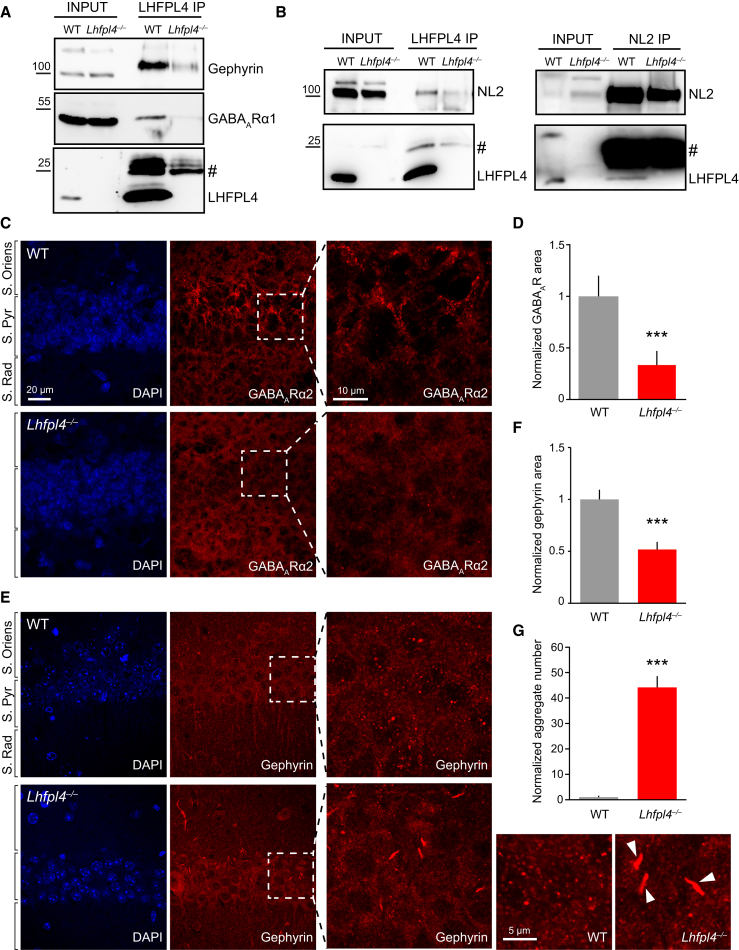
LHFPL4 Is Necessary for Gephyrin and GABAAR Clustering in Intact Brain(A) Co-immunoprecipitation (coIP) of gephyrin and GABAAR-α1 using an anti-LHFPL4 antibody from WT and Lhfpl4−/− mouse brain lysates (IP, immunoprecipitation; #, immunoglobulin G [IgG] light chain). Note that the immunoprecipitated 27-kDa band is visible just above the IgG light chain in the WT IP lane.(B) CoIP of neuroligin2 (NL2) using an anti-LHFPL4 antibody (left) and coIP of LHFPL4 using an anti-NL2 antibody (right) from WT and Lhfpl4−/− mouse brain lysates (IP, immunoprecipitation; #, IgG light chain).(C–F) Confocal images of adult WT and Lhfpl4−/− hippocampal brain sections immunolabeled with antibodies to (C) GABAAR-α2 and (E) gephyrin, co-stained with DAPI. Normalized total cluster area quantification of (D) GABAAR-α2 and (F) gephyrin showing a loss of GABAAR-α2 (from 1.0 ± 0.2 to 0.3 ± 0.1; n = 17 WT and 19 KO hippocampi from 4 animals per genotype; p = 0.0083) and gephyrin (from 1.0 ± 0.1 to 0.5 ± 0.1; n = 16 WT and 12 KO hippocampi from 3 animals per genotype; p = 0.0004) clustering in Lhfpl4−/− tissue.(G) Bar graph showing increased large gephyrin aggregates in Lhfpl4−/− compared to WT brain slices (from 1.0 ± 0.6 to 44.2 ± 4.4; n = 15 WT and 14 KO regions from 3 animals per genotype; p < 0.0001). White arrowheads indicate gephyrin aggregates in the zoom image. In (D), (F), and (G), error bars indicate mean ± SEM.∗p < 0.05; ∗∗∗p < 0.001 (Welch t tests).